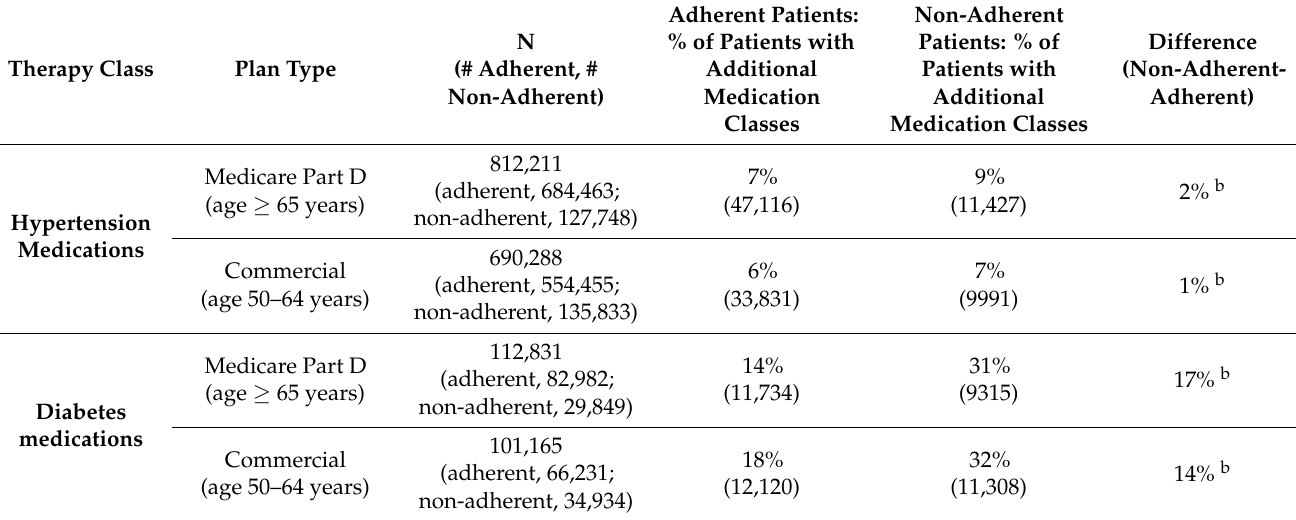
Table 3. Difference in fills of additional medication classes between non-adherent and adherent patients a